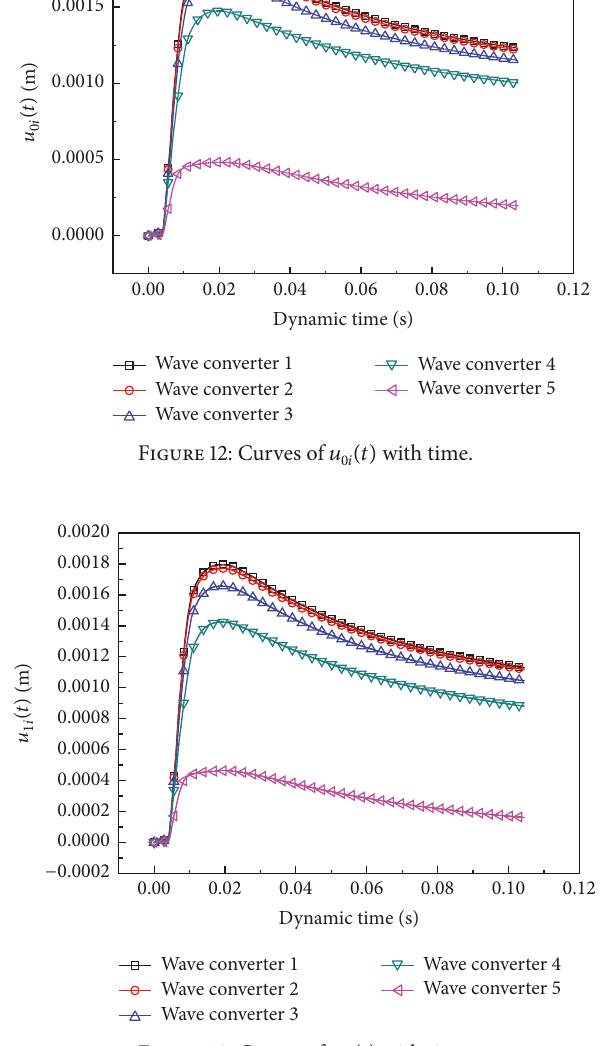
Figure 13: Curves of 𝑢 1𝑖 (𝑡) with time.